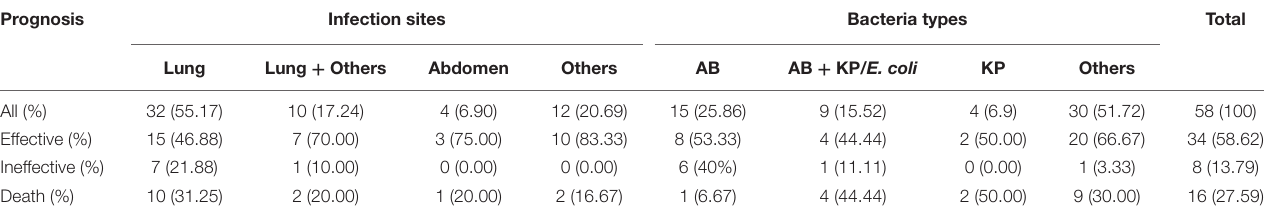
TABLE 2 | Infectious profiles and clinical outcomes of the patients who underwent TDM.